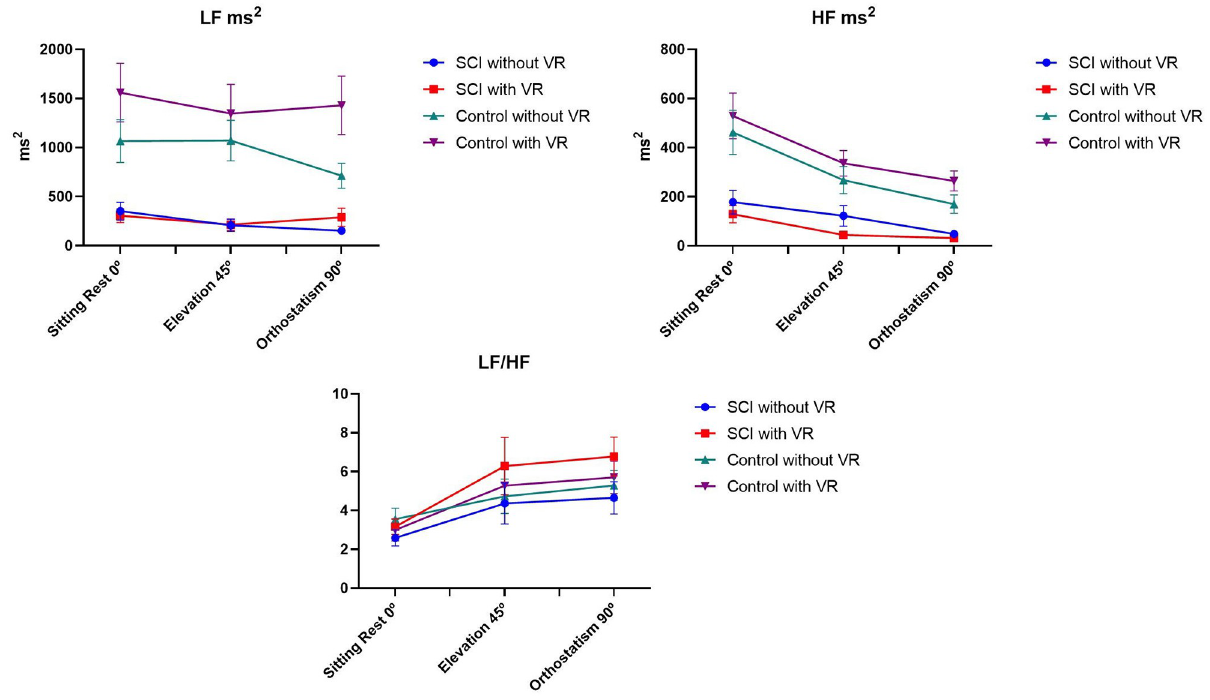
Fig 4. Representation of the mean and standard error of the indices of the frequency domain for SCI and able-bodied controls, at the three moments (Sitting rest 0˚, elevation 45˚, and orthostatism 90˚), with and without virtual reality. SCI: spinal cord injury; VR: Virtual Reality activity; bpm: beats per minute; ms 2 : millisecond squared; HF: high frequency; LF: low frequency; LF / HF: ratio of low frequency and high frequency.